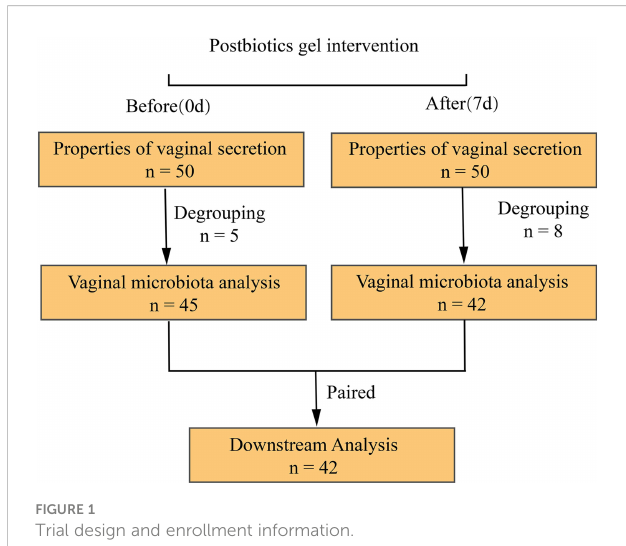
FIGURE 1 Trial design and enrollment